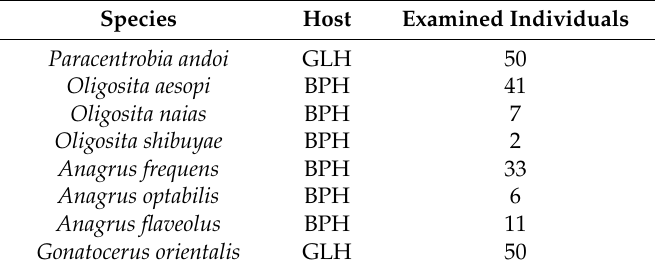
Table 1. Species identified by the morphological analysis using 50 specimens per genera (GLH: green leafhopper, BPH: brown